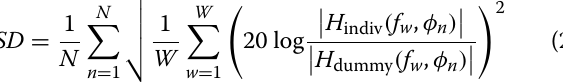
fluctuations due to reflections not completely eliminated in the measured BRIR. A threshold of − 30 dB provides high accuracy in the detection of local HRIR maximums, while ensuring homogeneous estimates between differ- ent subject measurements. According to previous studies [50], the chosen method closely resembles the percep-